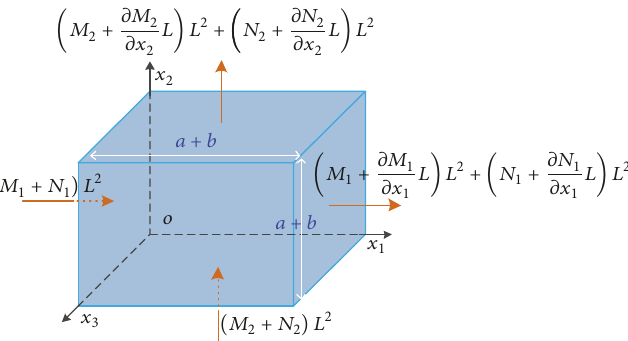
Figure 6: Illustration of a three-dimensional characteristic element in a KCP. 𝑀 𝑖 and 𝑁 𝑖 are mass change of solids due to convection and diffusion, respectively, defined as 𝑀 𝑖 = 𝐶𝜌 𝑠 𝑞 𝑖 , 𝑁 𝑖 = −𝐷(𝜕(𝐶𝜑𝜌 𝑠 )/𝜕𝑥 𝑖 )